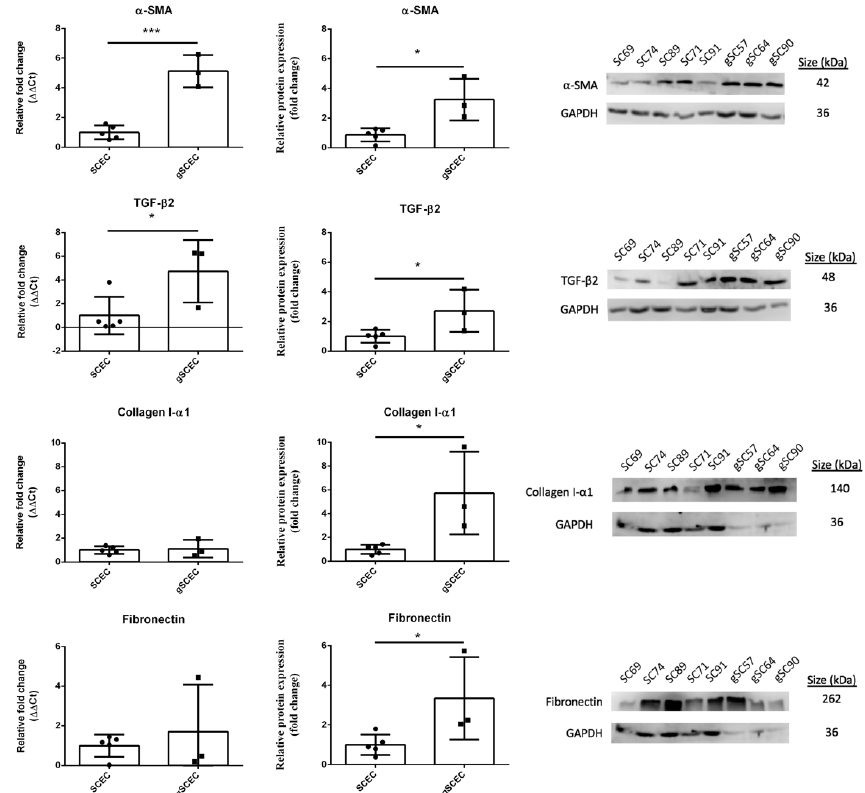
Figure 1. Relative expression of α -SMA, TGF- β 2, collagen I- α 1 and fibronectin in heathy versus glaucomatous SCECs. Shown are mRNA transcript (left column) and protein (middle column) quantification of the fibrotic markers, α -SMA, collagen I- α 1, and fibronectin, as well as pro-fibrotic cytokine TGF- β 2 in gSCECs relative to healthy SCECs. Representative blots are shown in the right columns. A significant increase in α -SMA transcript ( p = 0.0003) and protein ( p = 0.0105) expression was observed between gSCECs and SCECs. A significant increase in TGF- β 2 transcript ( p = 0.0431) and protein ( p = 0.0389) expression was also observed between gSCECs and SCECs. While no significant difference in collagen I- α 1 and fibronectin transcript expression was observed ( p > 0.05), a significant increase in both collagen I- α 1 ( p = 0.0190) and fibronectin ( p = 0.0457) protein expression was observed in gSCECs, compared to SCECs. Mean +/ − SD is shown above with each data point representing an individual biological sample, n = 5 for SCEC and n = 3 for gSCEC. Statistical analysis was carried out using an unpaired Student’s t -test and statistical significance was indicated by the following * = ( p < 0.05) and *** = ( p <